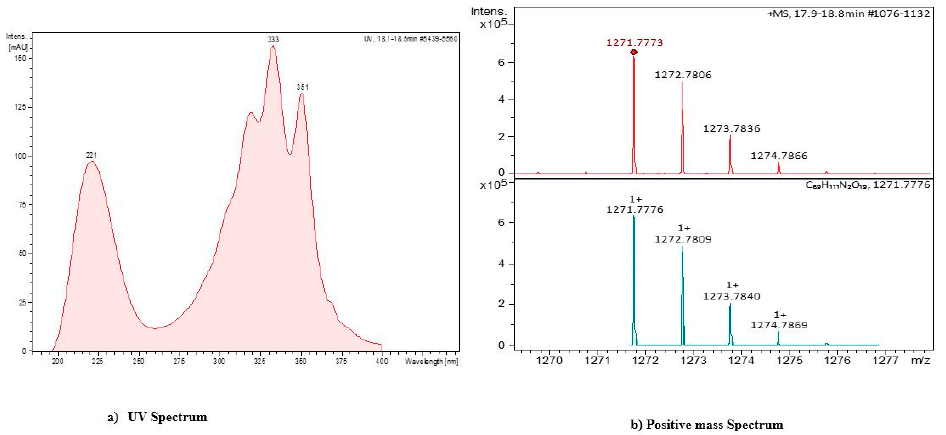
Figure 6. Characteristics of unidentified metabolite from the Streptomyces isolate BR123 based on ( a ) UV spectrum; ( b ) HPLC-MS analysis.